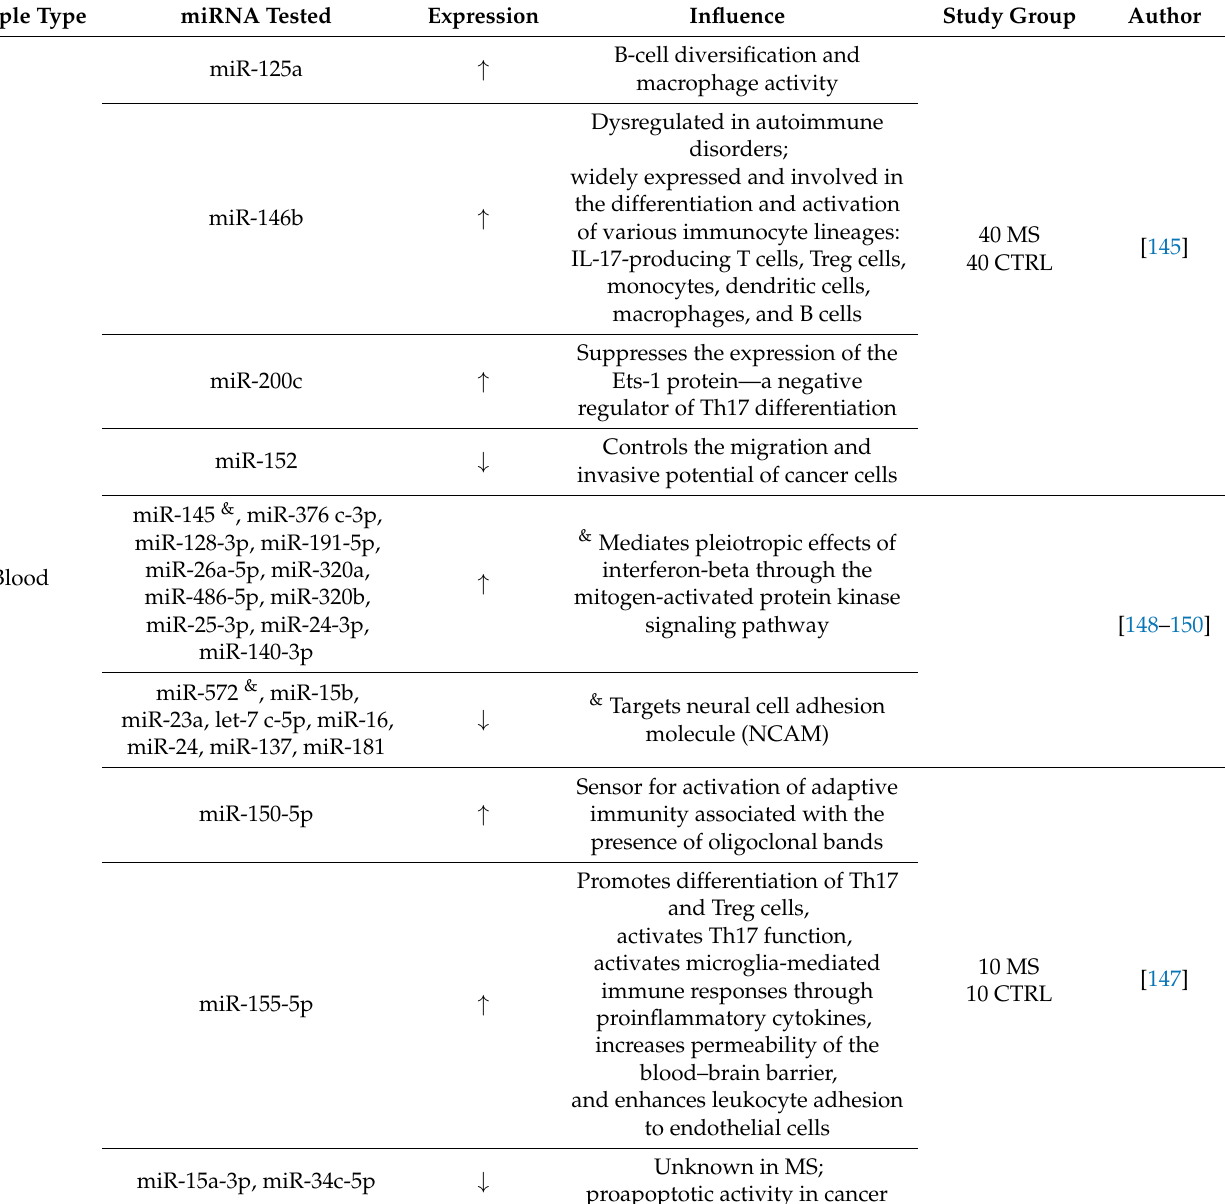
Table 4. Molecular biomarkers of